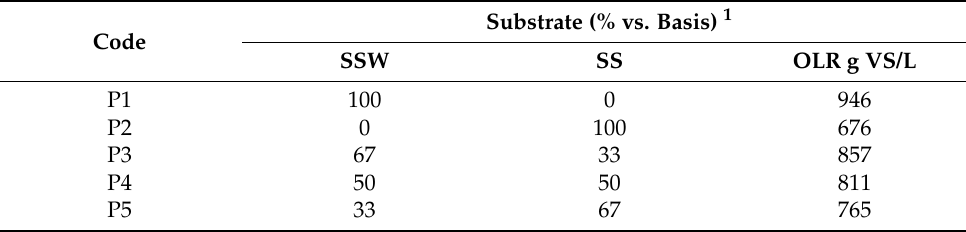
Table 2. Experimental design of anaerobic codigestion experiment of SSW with SS and its mixtures.